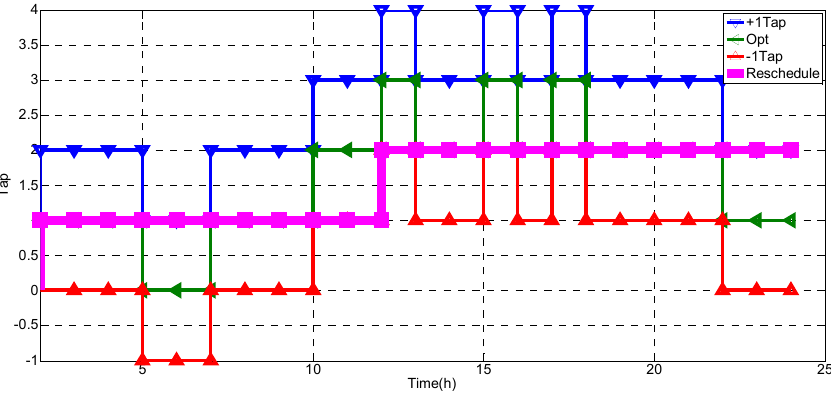
Figure 15. Illustration of tap schedule adjustment of the proposed method.